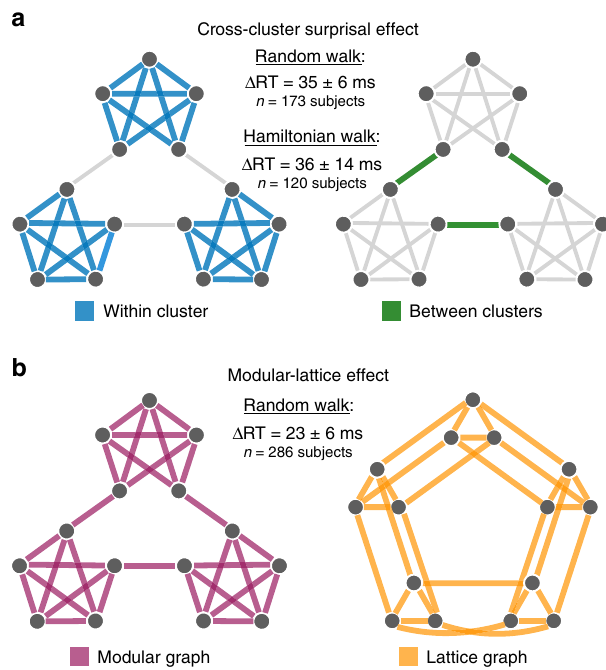
Fig. 2 The effects of higher-order network structure on human reaction times. a Cross-cluster surprisal effect in the modular graph, de fi ned by an average increase in reaction times for between-cluster transitions (right) relative to within-cluster transitions (left). We detect signi fi cant differences in reaction times for random walks ( p < 0.001, t = 5.77, df = 1.61 × 10 5 ) and Hamiltonian walks ( p = 0.010, t = 2.59, df = 1.31 × 10 4 ). For the mixed effects models used to estimate these effects, see Supplementary Tables 1 and 3. b Modular-lattice effect, characterized by an overall increase in reaction times in the lattice graph (right) relative to the modular graph (left). We detect a signi fi cant difference in reaction times for random walks ( p < 0.001, t = 3.95, df = 3.33 × 10 5 ); see Supplementary Table 2 for the mixed effects model. Measurements were on independent subjects, statistical signi fi cance was computed using two-sided F -tests, and con fi dence intervals represent standard deviations. Source data are provided as a Source Data fi